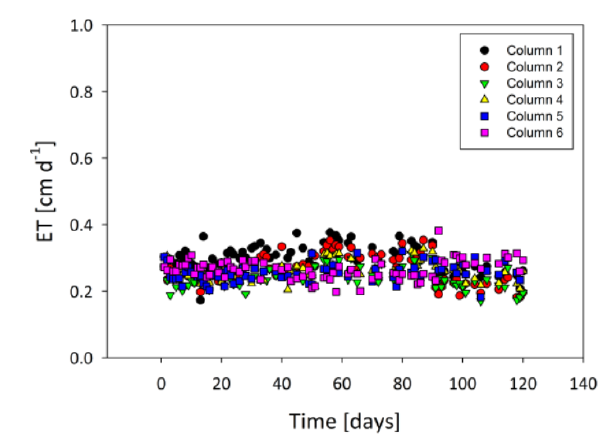
Figure A5. Calculated ET during the experiment. Data presented are for each column separately (color coded; see